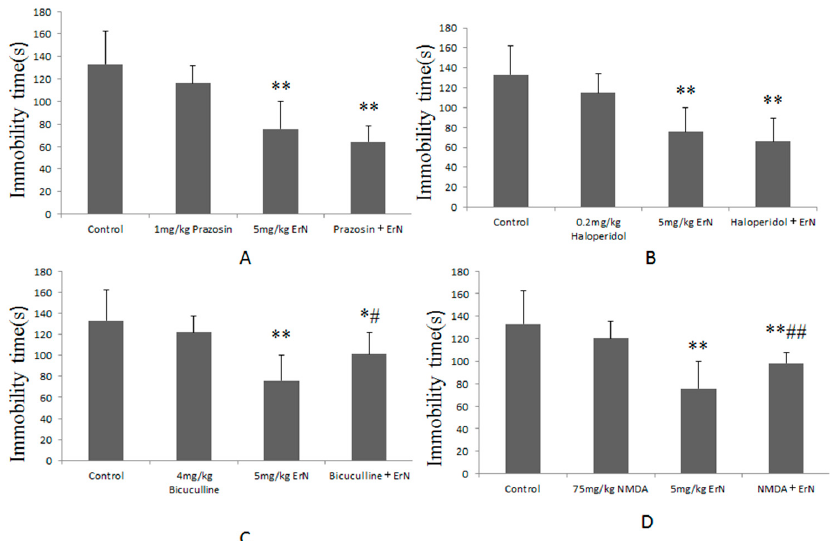
Figure 3. ( A ) shows effects of pre-treatment with prazosin (1mg/kg, i.p.) on the antidepressant-like effect induced by ErN (5 mg/kg, i.p.) in the FST; ( B ) shows effects of pre-treatment with haloperidol (0.2 mg/kg, i.p.) on the antidepressant-like effect induced by ErN (5 mg/kg, i.p.) in the FST; ( C ) shows effects of pre-treatment with bicuculline (4 mg/kg, i.p.) on the antidepressant-like effect induced by ErN (5 mg/kg, i.p.) in the FST; ( D ) shows effects of pre-treatment with NMDA (75 mg/kg, i.p.) on the antidepressant-like effect induced by ErN (5 mg/kg, i.p.) in the FST. The values represent the mean ± SD ( n = 10 in each group), compared with control group, * p < 0.05, ** p < 0.01; compared with ErN group, # p < 0.05, ## p < 0.01. One way ANOVA, post-hoc Tukey test.